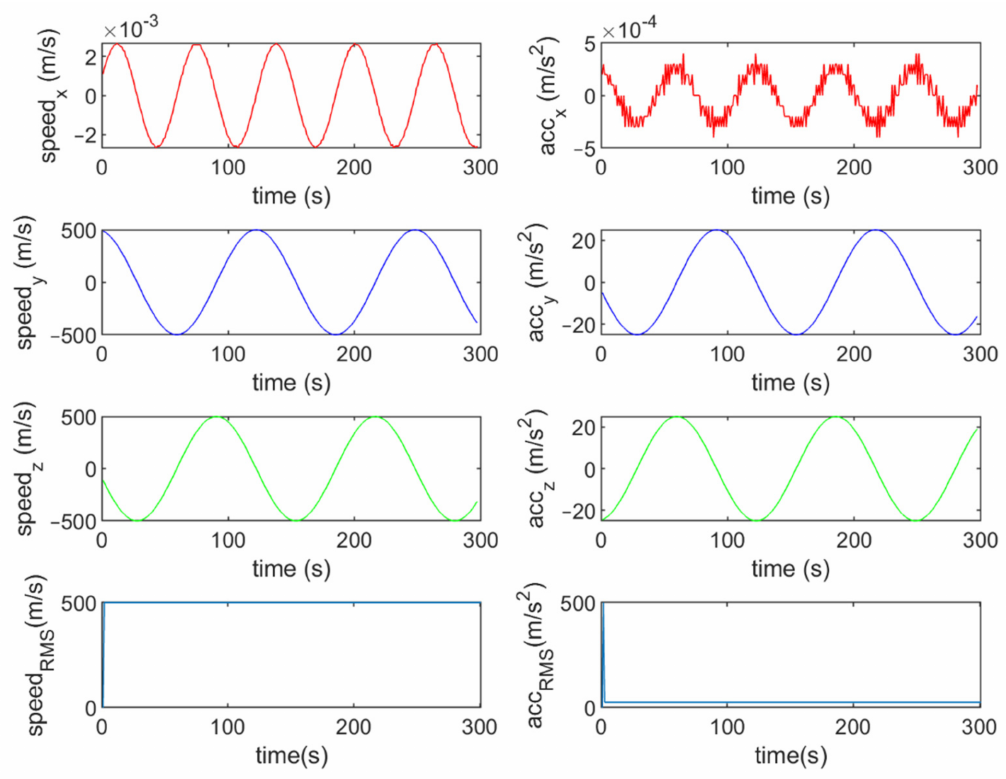
Figure 12. The speed and acceleration components in the third scenario.